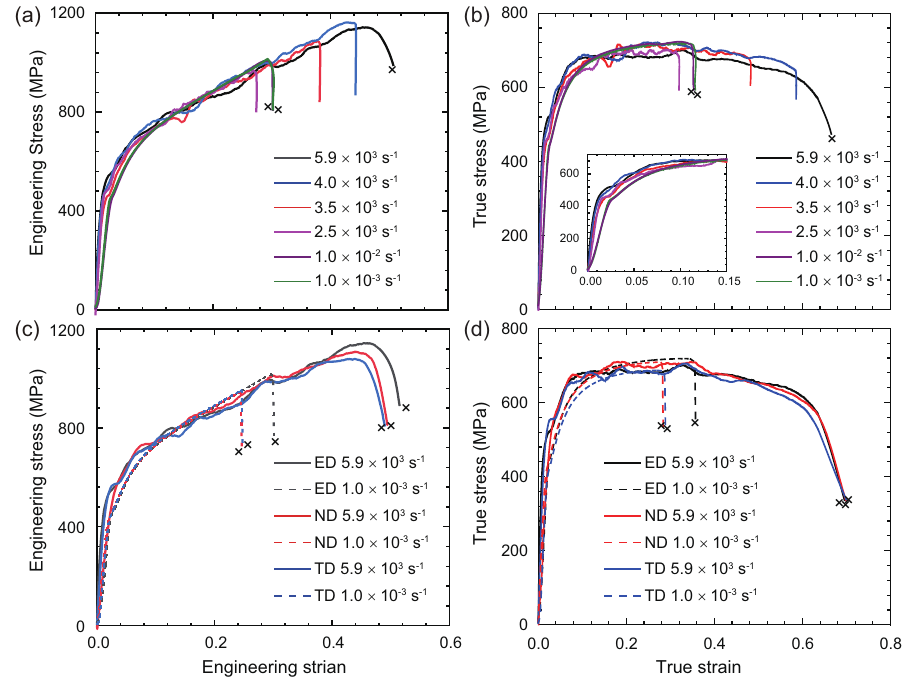
Figure 3. ( a ) Engineering stress–strain curves and ( b ) true stress–strain curves under different strain rates for compression loading along the ED. ( c ) Engineering stress–strain curves and ( d ) true stress– strain curves for dynamic (strain rate 5.9 × 10 3 s − 1 ) and quasi-static (10 − 3 s − 1 ) compression loading along the ED, ND and TD. The cross symbols indicate the catastrophic